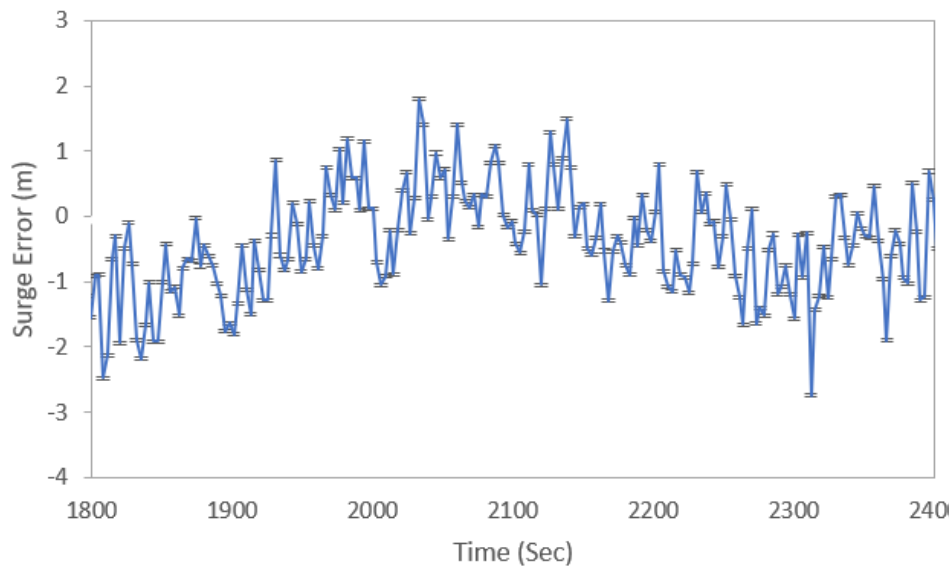
Figure 14. Surge response error between ANN and FEM model results for wave height of 12.65 m and wave period of 11.39 s.